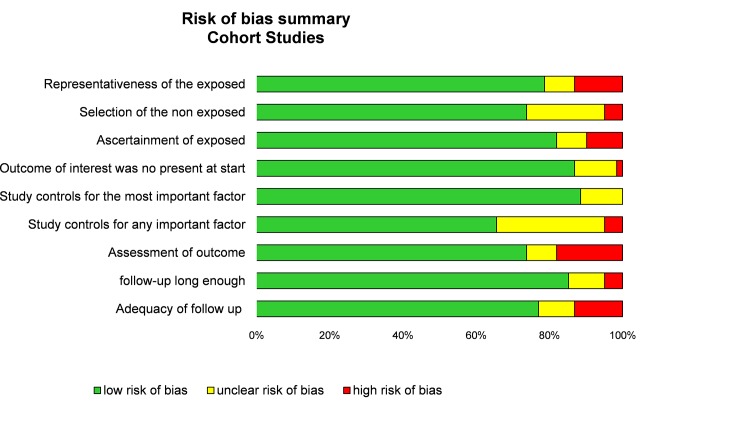
Summary bias risk of included articles using the Newcastle–Ottawa Quality Assessment Scale model.